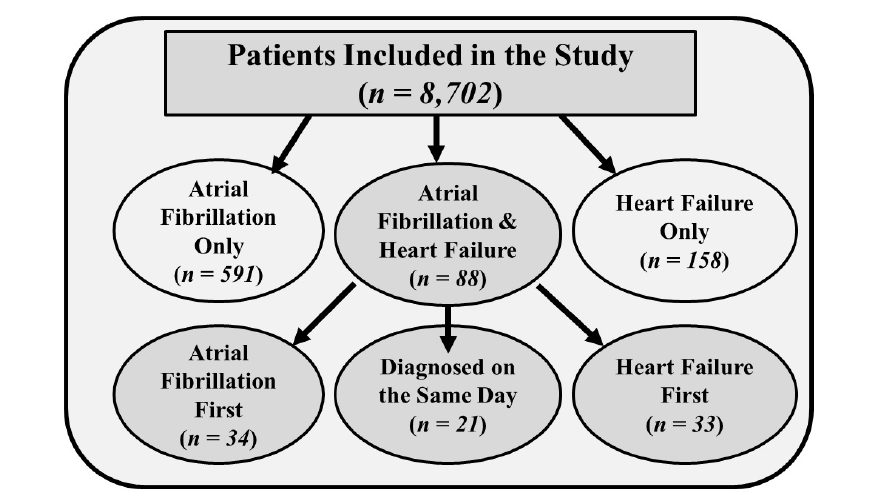
Figure 1. Timing and distribution of patients with atrial fibrillation, heart failure, or both Impact of developing atrial fibrillation on heart failure and vice versa